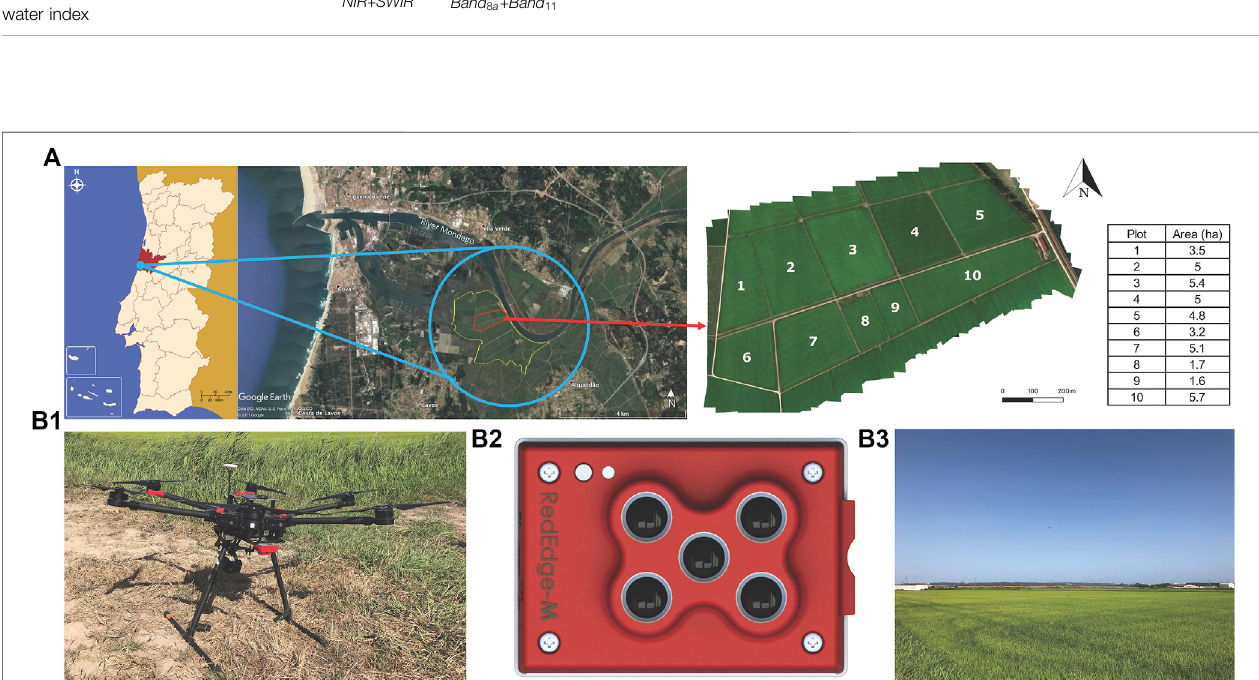
FIGURE 1 | Study site and UAS survey. (A) Location of the rice production irrigation area “ Quinta do Canal, ” in Portugal (adapted from Google Maps, 2021) and limits of the ten selected study fi eld plots and (B) Views of the UAS fi eld survey in Quinta do Canal (July 9, 2020): (b1) DJI Matrice 600 drone, (b2) Micasense RED Edge — M multispectral sensor, and (b3) rice fi